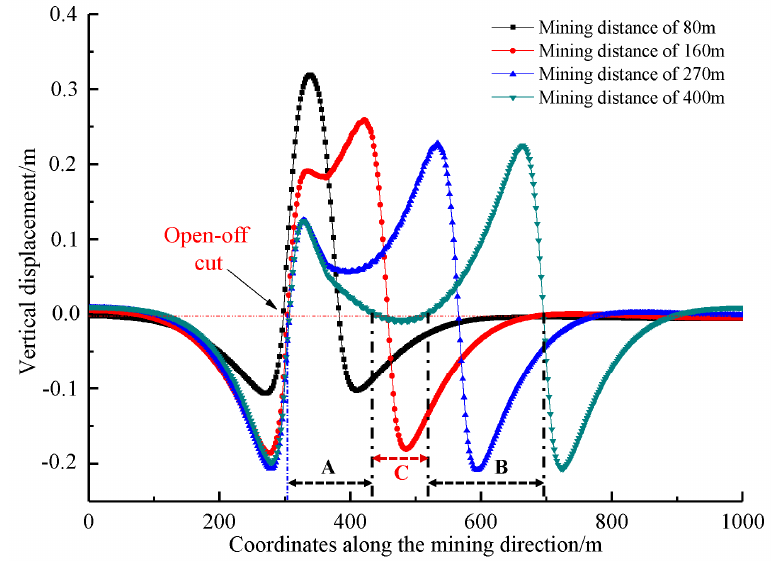
Figure 5. Vertical displacement of the No. 3–5 coal seam in the mining process of the No. 4 seam.